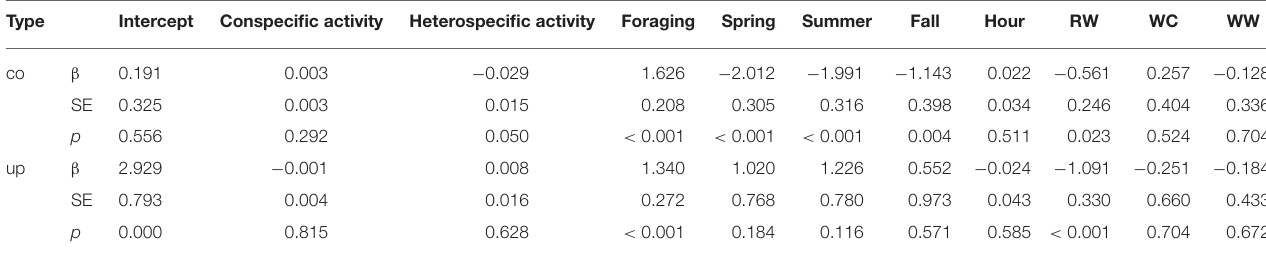
TABLE 6 | Multinomial logistic regression results for the effect of hourly conspecific activity, hourly heterospecifics activity, foraging, season, hour after sunset and site on social calling bout type for Eptesicus fuscus . Type